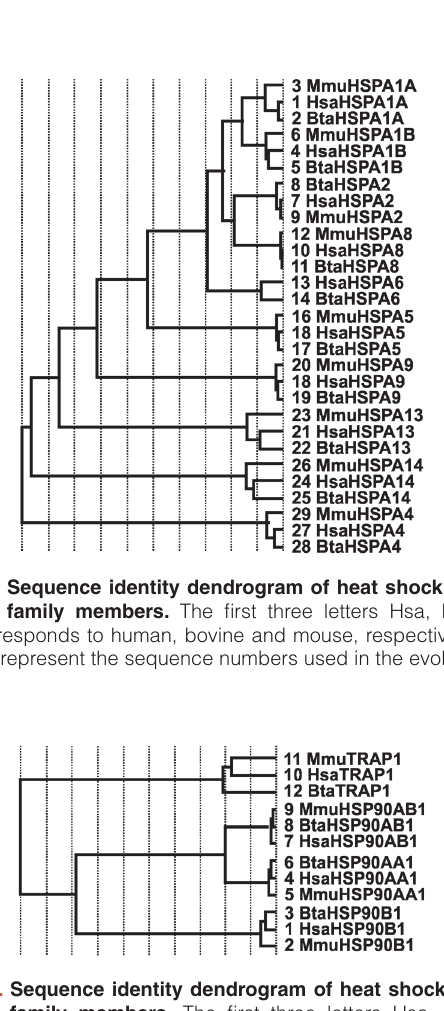
Figure 8. Sequence identity dendrogram of heat shock protein 90 gene family members. The first three letters Hsa, Bta and Mmu corresponds to human, bovine and mouse, respectively. The numbers represent the sequence numbers used in the evolutionary trace